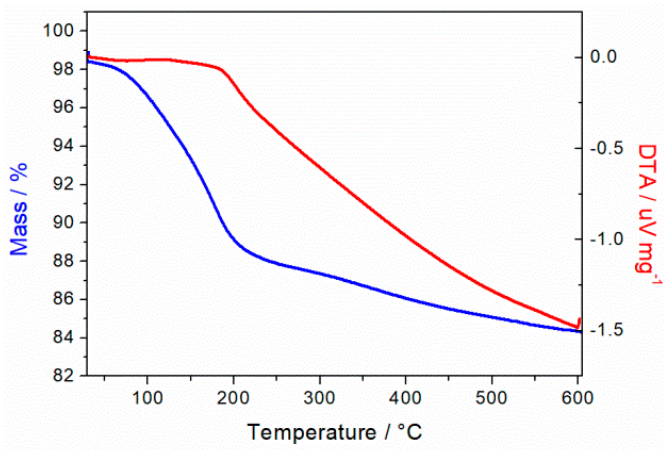
Figure 4. TGA measurements of MnO 2 powder after synthesis in N 2 at 40 mL min − 1 , 10 ◦ C min − 1 heat ramp under atmospheric pressure.